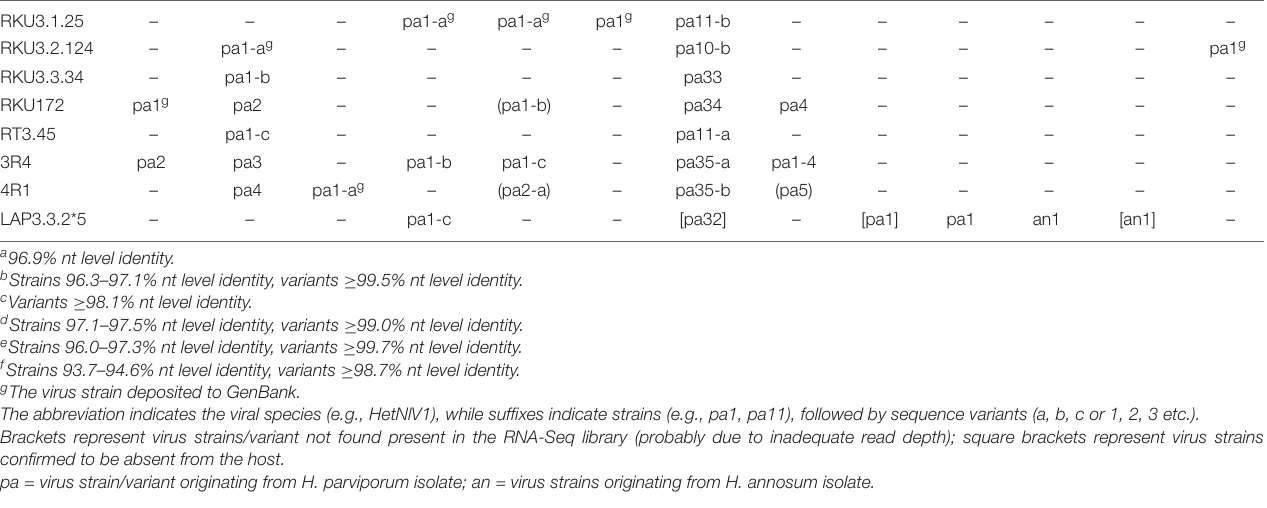
TABLE 2 | Presence/absence of virus strains and variants in the H. parviporum isolates included in the RNA-Seq library.